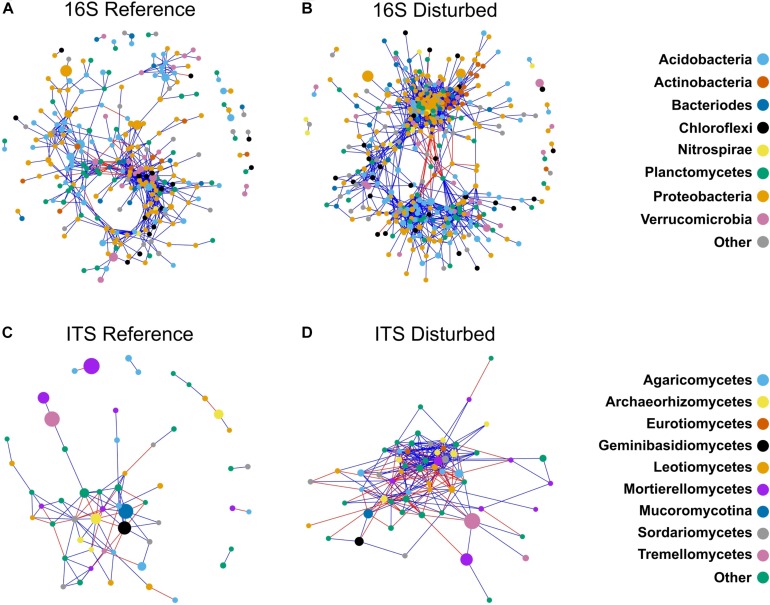
Co-occurrence networks constructed for bacterial communities in reference watersheds (A), disturbed watersheds (B) and fungal communities in reference watersheds (C), and disturbed watersheds (D). Color of nodes is indicative of bacterial phylum (A,B) or fungal class (C,D). Edge color is indicative of positive (blue), or negative (red) correlations. Size of nodes is proportional to relative abundance of the OTU represented.